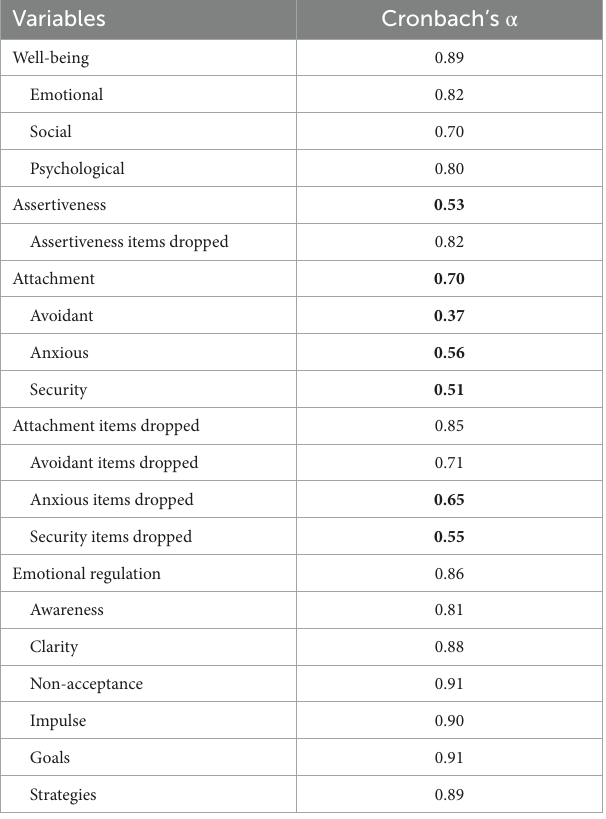
TABLE 4 Reliability analysis of the scales (well-being, assertiveness, attachment, and emotional regulation) before and after the items dropped